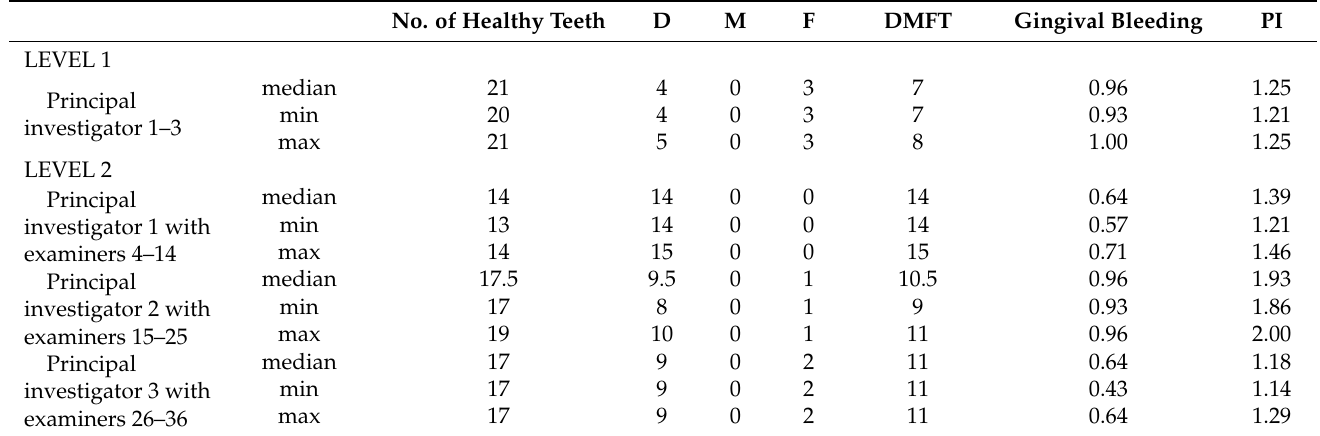
Table 1. Results of intra-examiner and inter-examiner reproducibility.